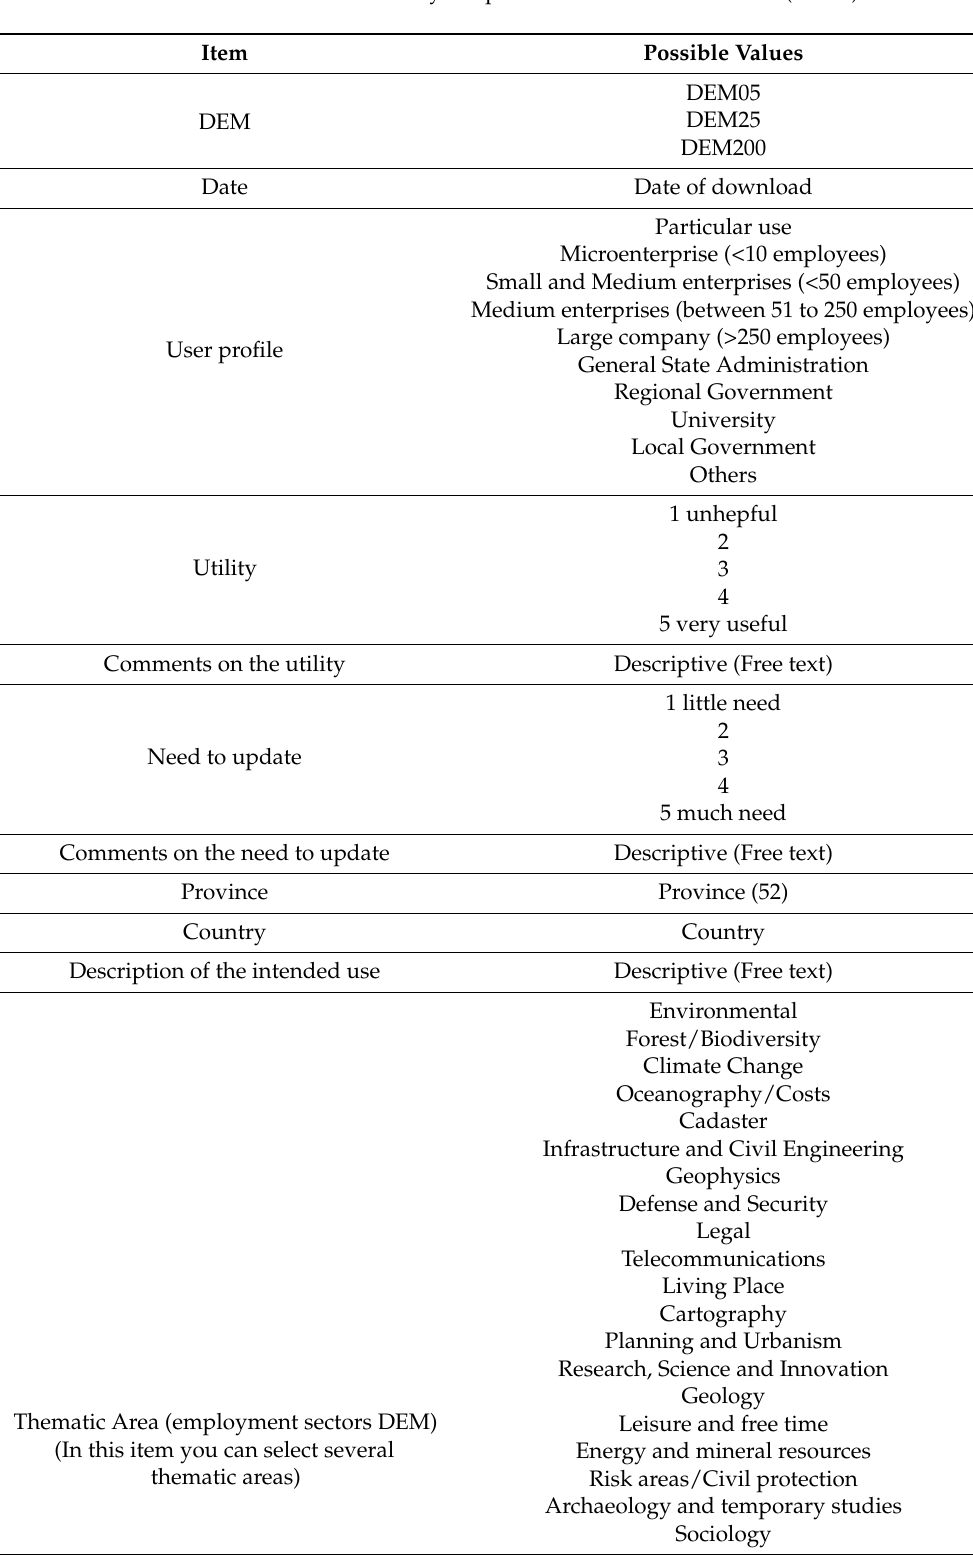
Table 1. Items of the web survey template of the Download Center